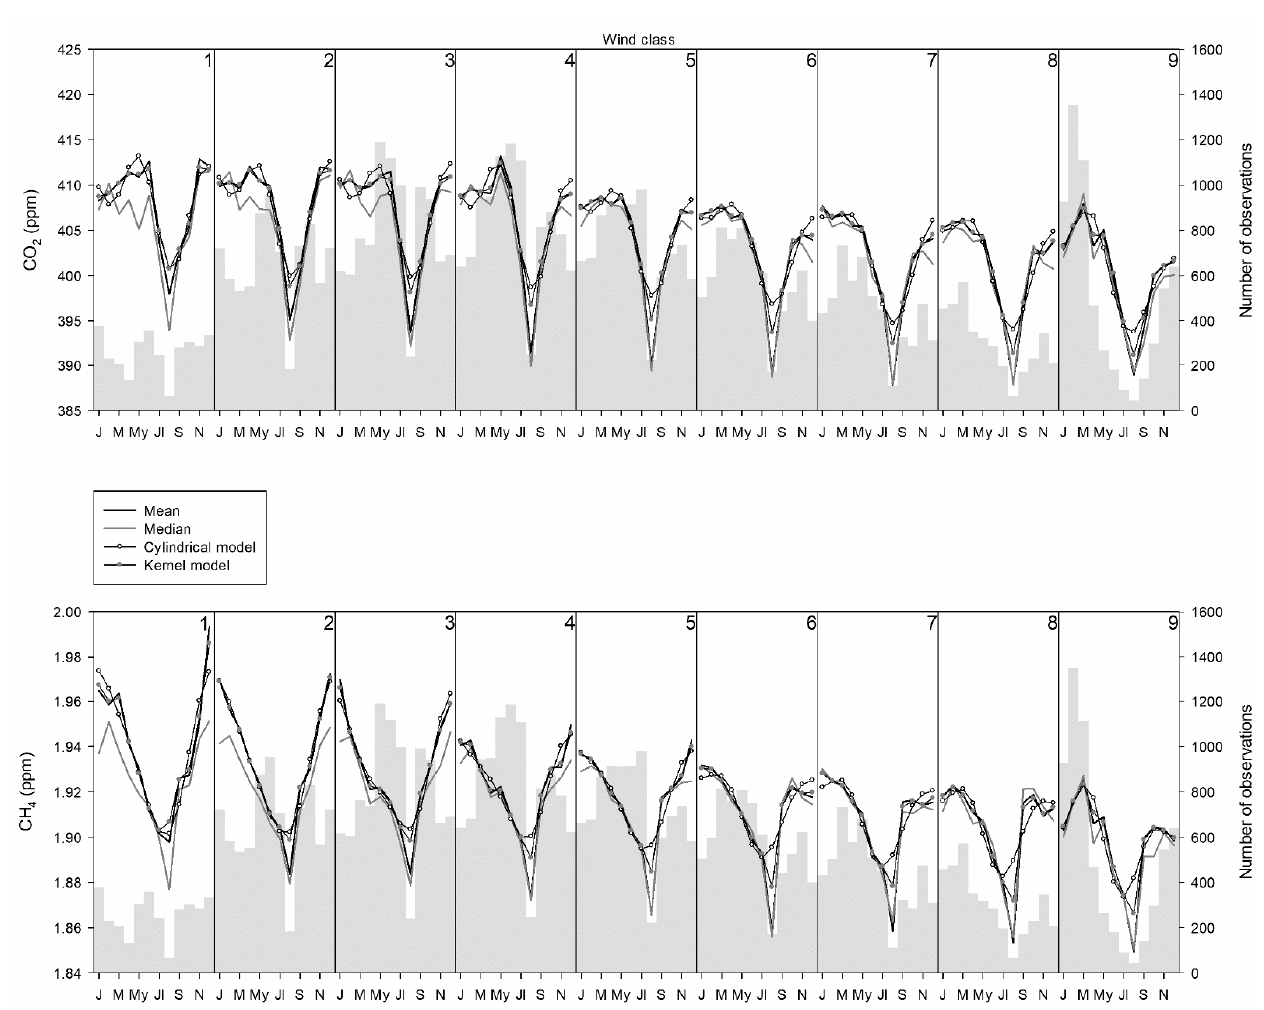
Figure 7. Annual cycle following the wind speed classification. Although the lowest concentration of both gases is reached in summer, especially in August, some differences between them are noticeable. Below 5 m · s − 1 , the interval of low concentrations for CO 2 was narrow, whereas it was prominent in the CH 4 annual cycle, with a gradual decrease in the first half of the year and a gradual increase after summer. Similar statistics were used to compare the means and modelled values (Table 4). The pattern of results was similar to that of the daily cycle, with the modified Nash–Sutcliffe efficiency followed by the modified index of agreement being the estimators with the lowest values. As with the distribution fitting, both statistics are sufficiently sensitive to the contrast between the values they evaluate and may be chosen against others that are more frequent, such as the correlation coefficient.